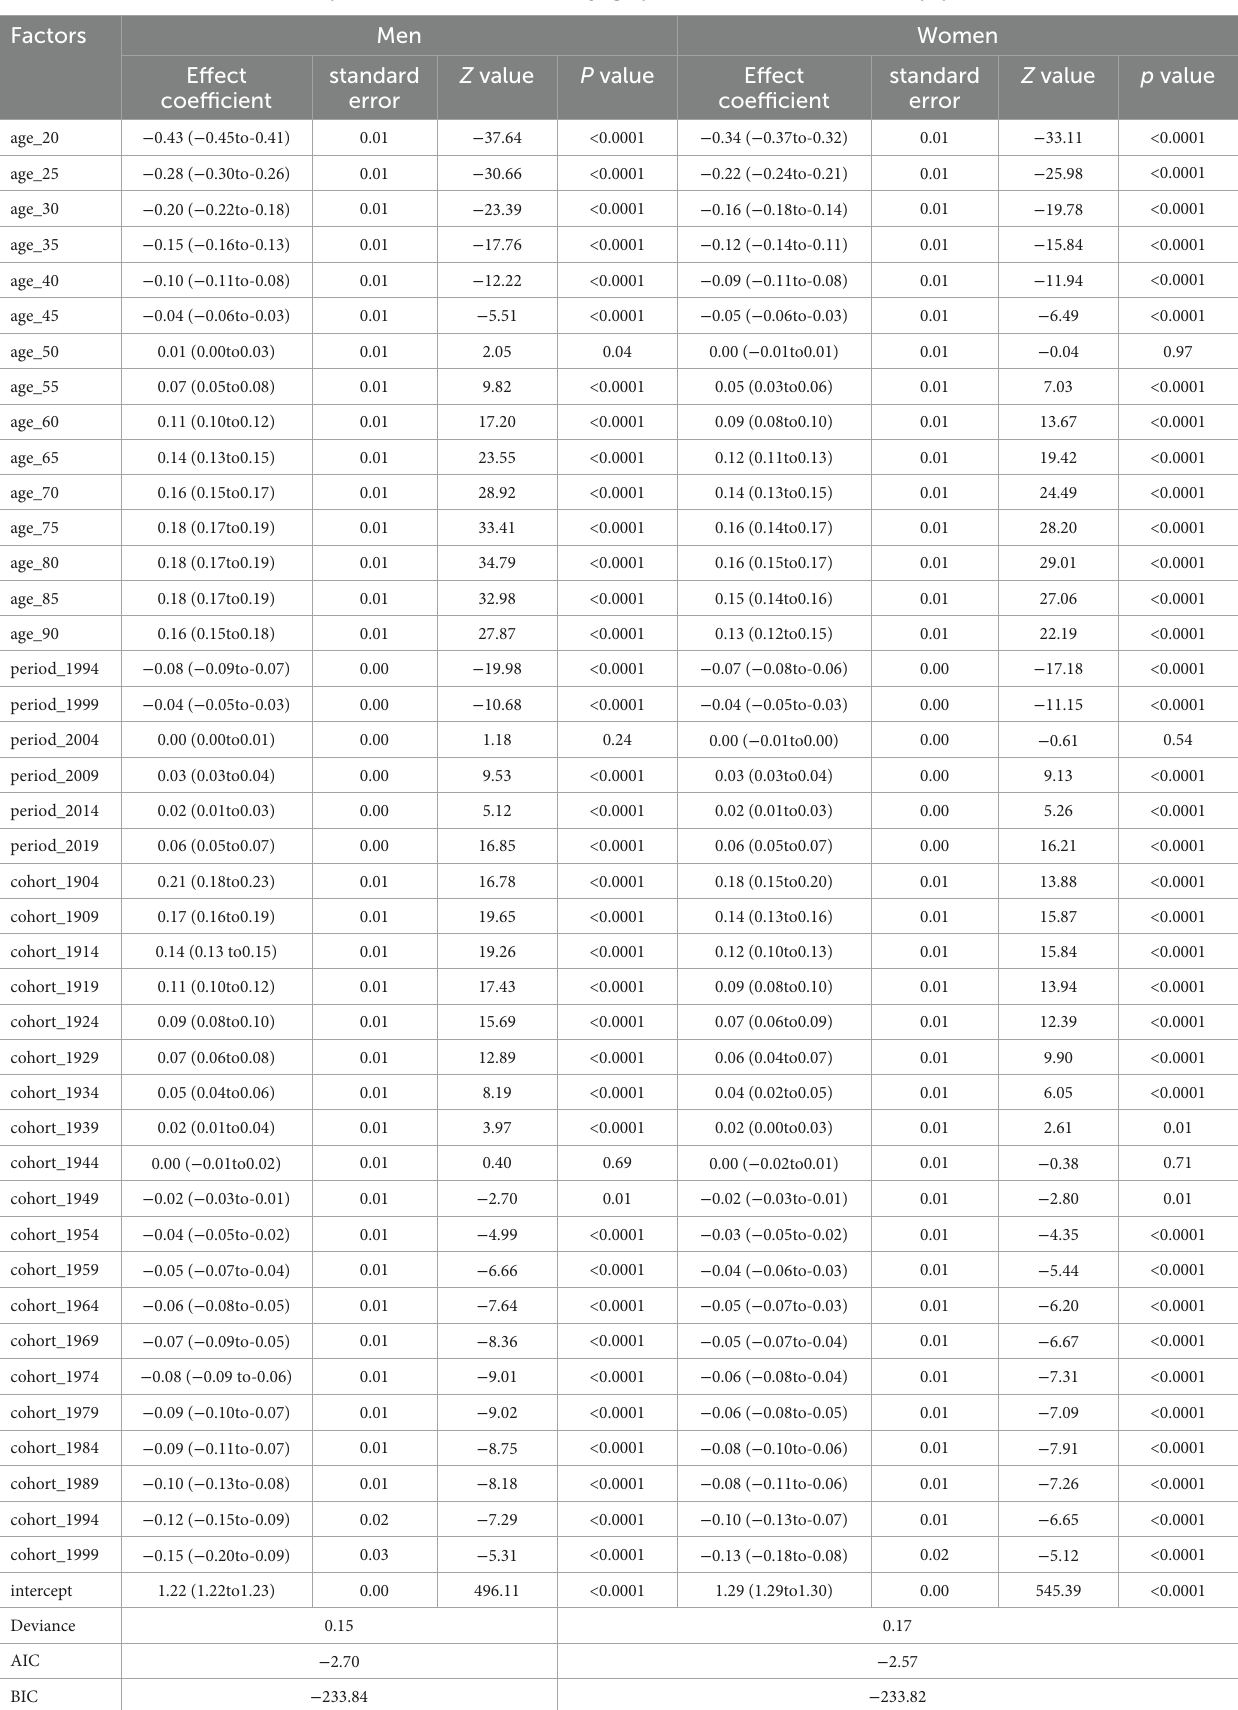
TABLE 1 Relative risk and 95% CI for the prevalence of edentulousness by age, period, and cohort in the Chinese population. Factors Men